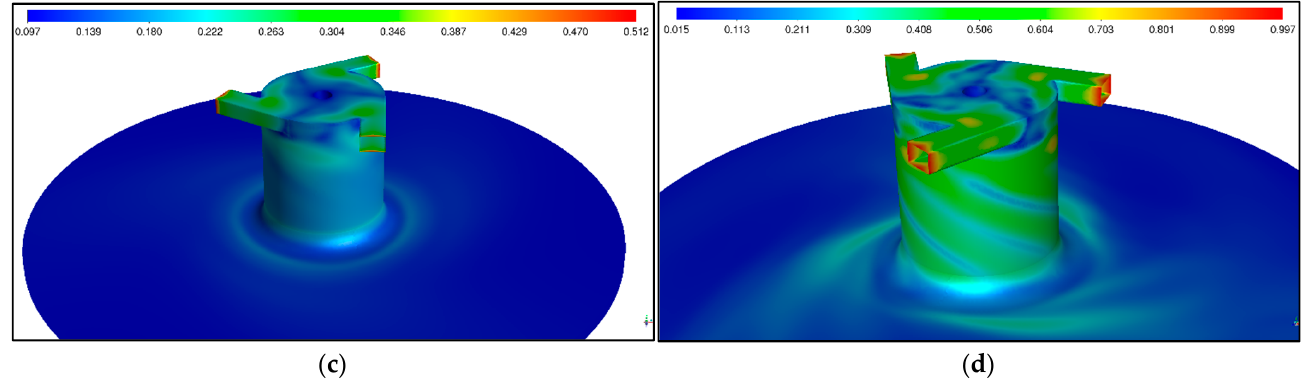
Figure 6. Contour of y + for SVT with ( a ) Ar ; ( b ) air ; ( c ) He ; and ( d ) CO 2 .